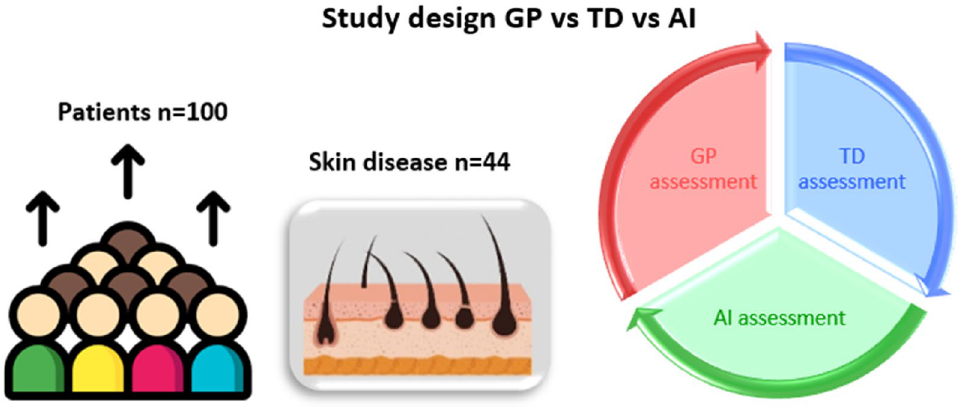
Figure 1. Study design general practitioner (GP) vs teledermatology (TD) vs artificial intelligence